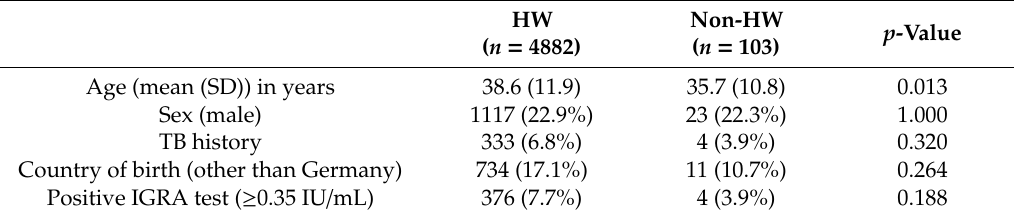
Figure 1. The propensity scores (PS) of the populations: at the top, the non-HWs were each matched with 10 suitable HWs. The lower point cloud shows the PS for the unmatched subjects from the HW population. Table 1. Group comparison of available subjects prior to matching.